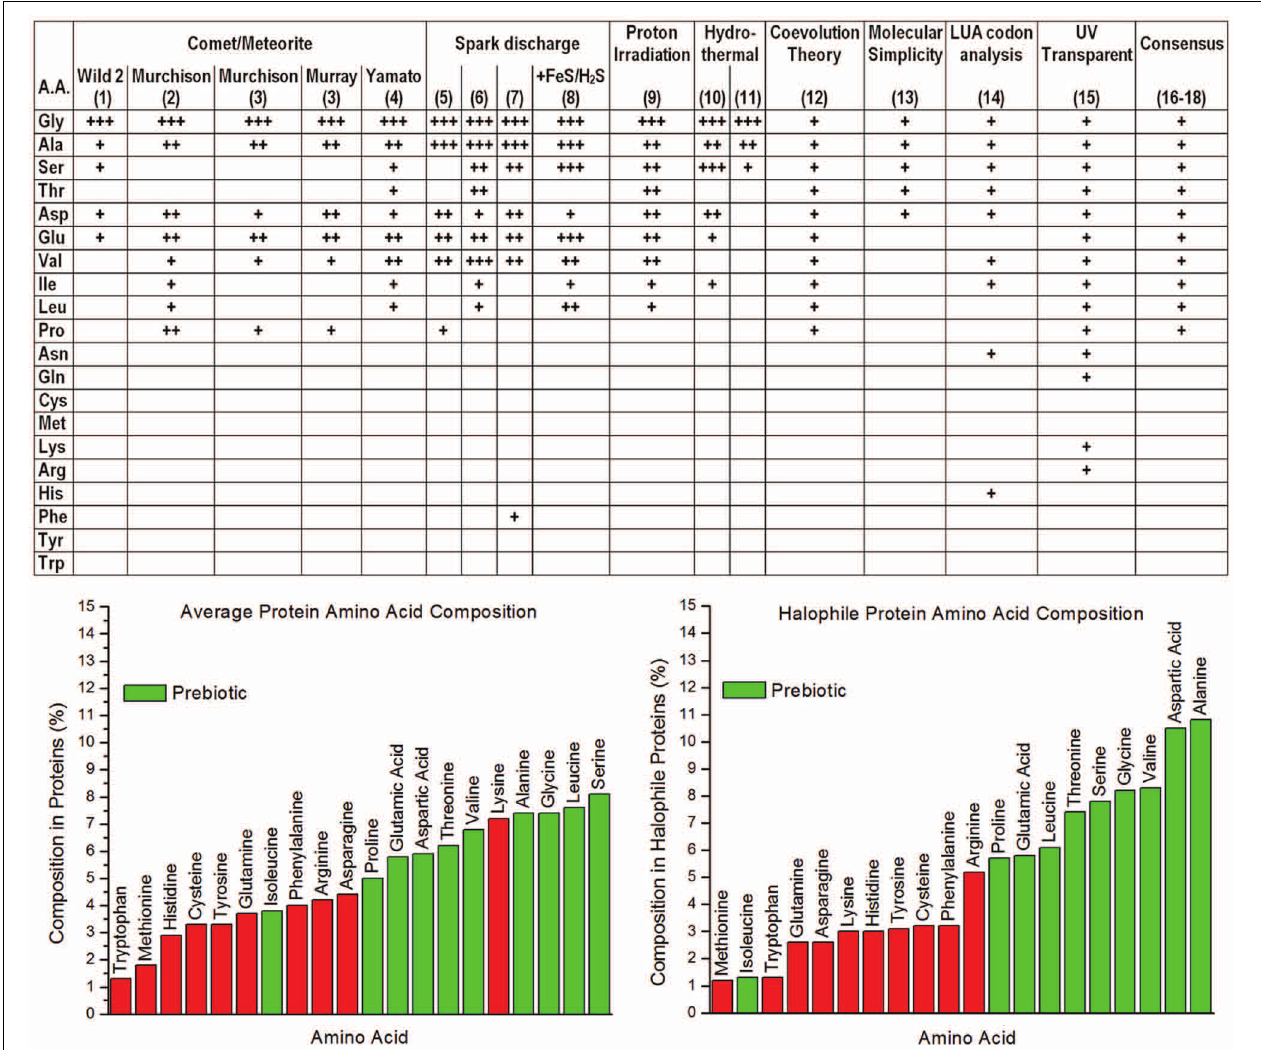
FIGURE 1 | Upperpanel: Consensusofprebioticavailabilityofthe20common proteogenic α -amino acids from analysis of comets/meteorites, Miller Urey type spark discharge experiments, proton irradiation synthesis, hydrothermal ventsynthesis,coevolutiontheory,molecularsimplicity,lastuniversalancestor codon analysis, and UV transparency [for references of datasets (1–8), (10–11), and (16–18) see Longo and Blaber (2012); (9) Takano et al. (2004); (12) Wong